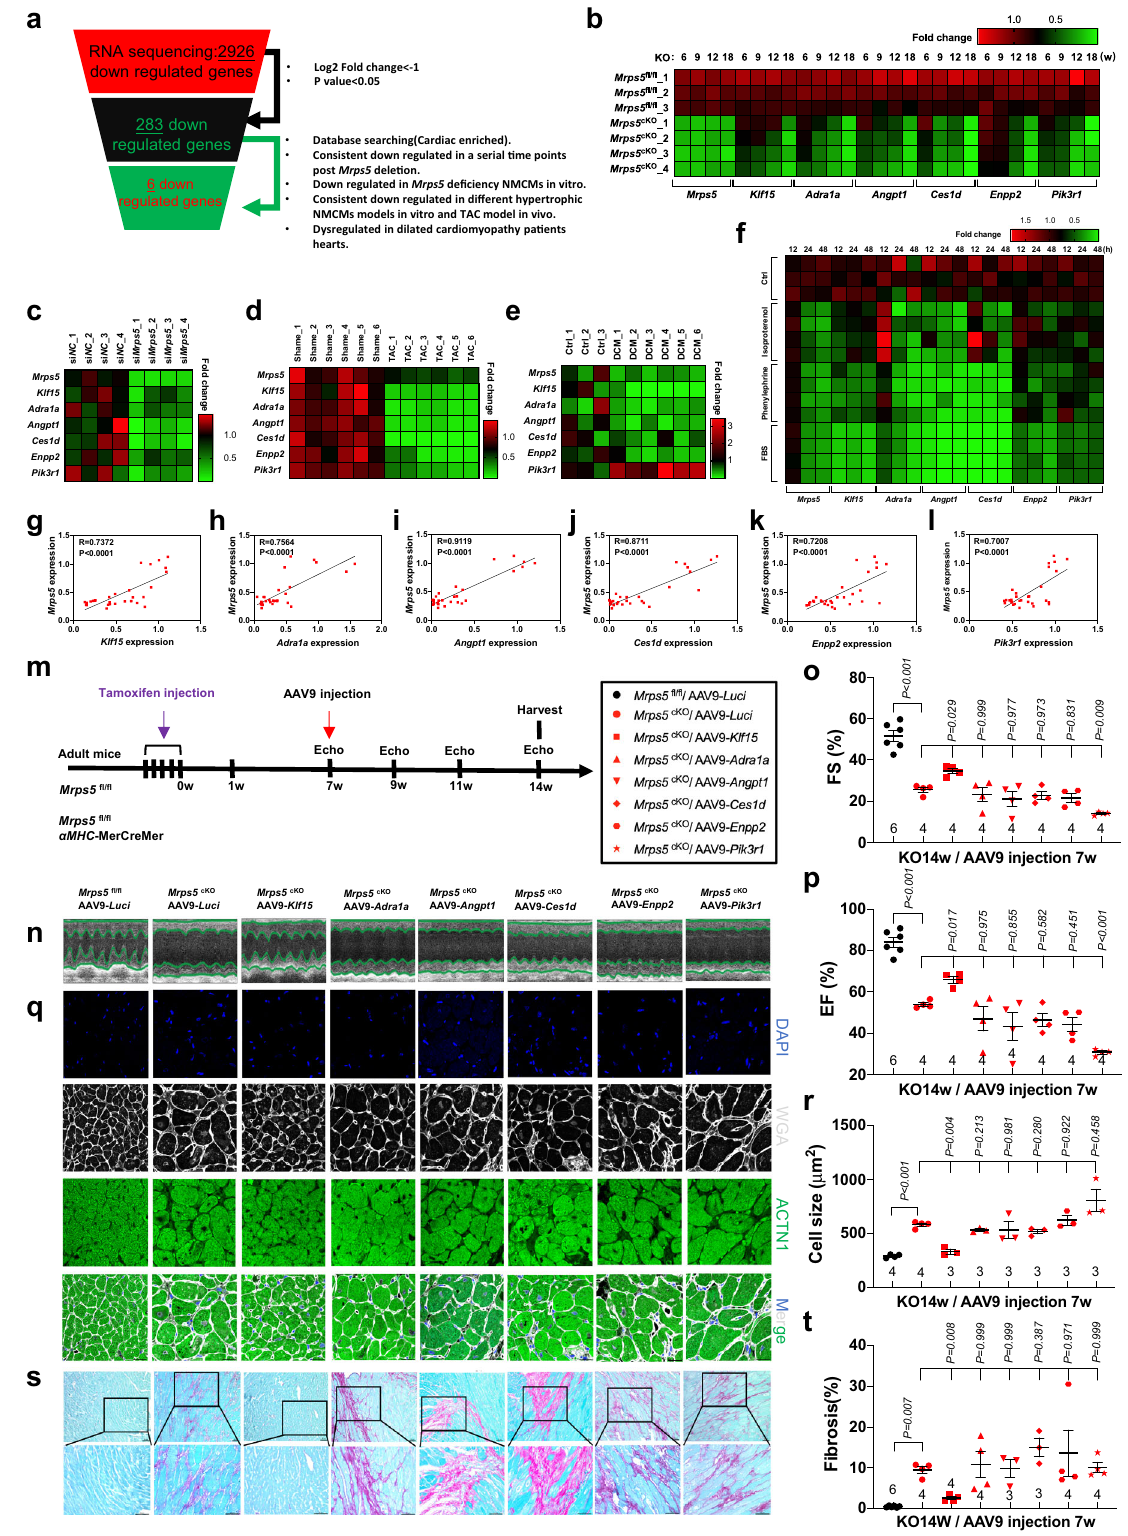
mitochondrial cristae structure was well preserved, and we also observed increased mitochondrial numbers and decreased mito- chondrial area (Fig. 6j – m). In contrast, control AAV9-Luci failed to rescue the cardiac defects in Mrps5 mutant mice (Fig. 6b – k). Sig- ni fi cantly, overexpression of Klf15 did not seem to cause any defect in control Mrps5 fl / fl mice (Fig. 6b – i).